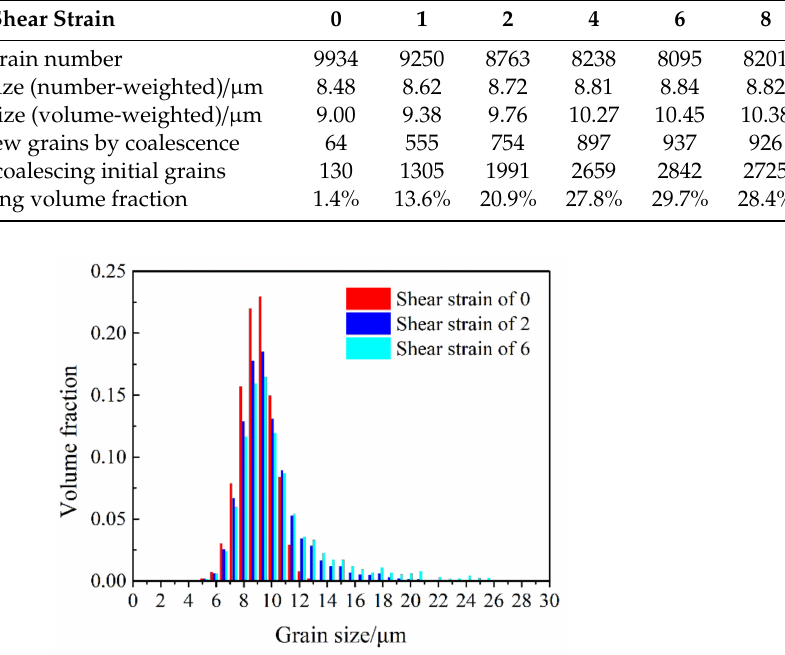
Figure 6. Variation of the grain size distribution as a function of shear strain, starting with random texture.